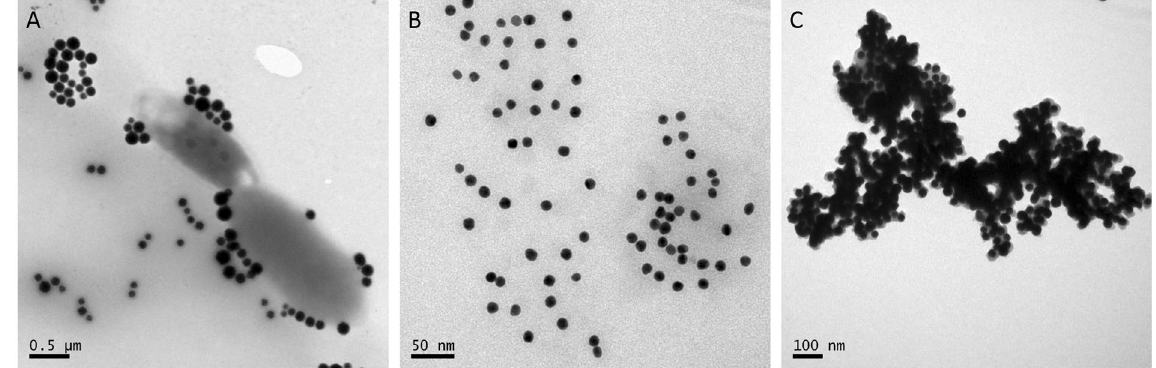
Figure 4. TEM imaging of EAbs modified MNPs coupled into bacterial cell surface ( A ); dextran@AuNPs before ( B ) and after ( C ) coupled with released Con A in the Final-solution.